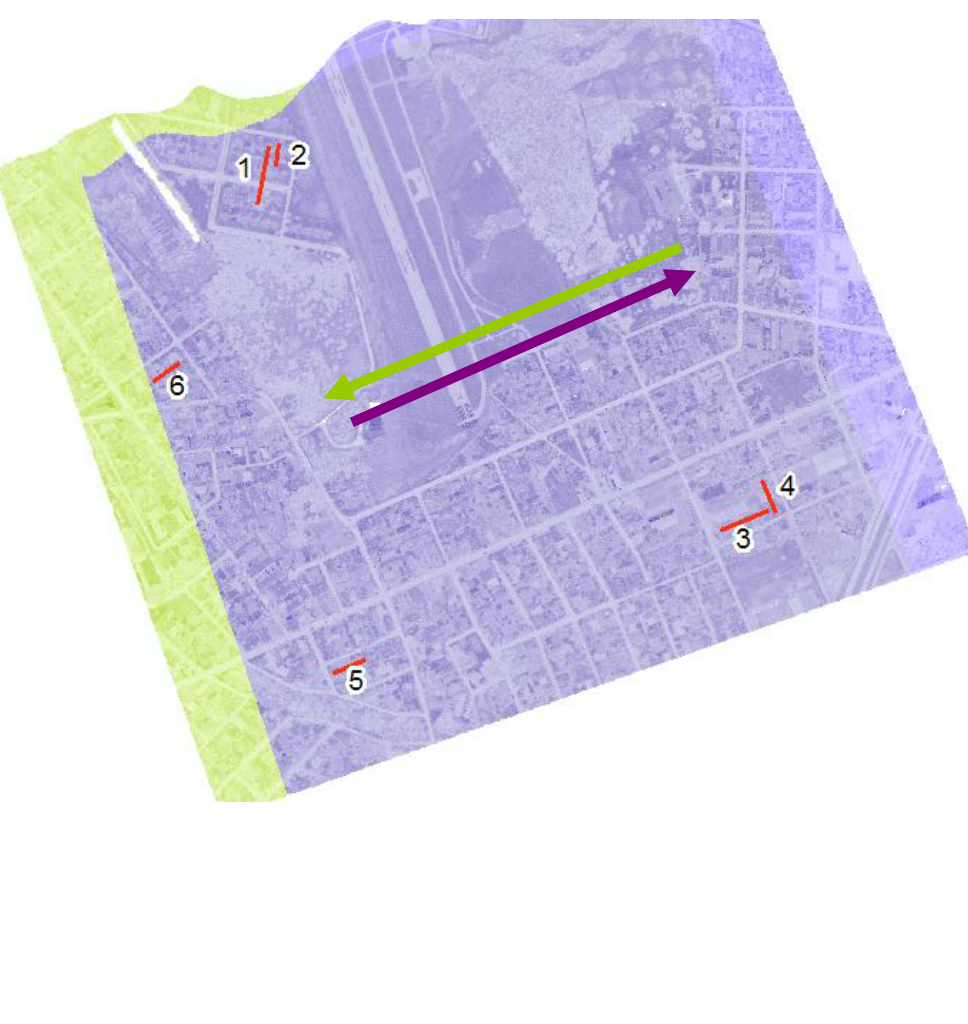
Figure 7. Profiles location along overlapping strips